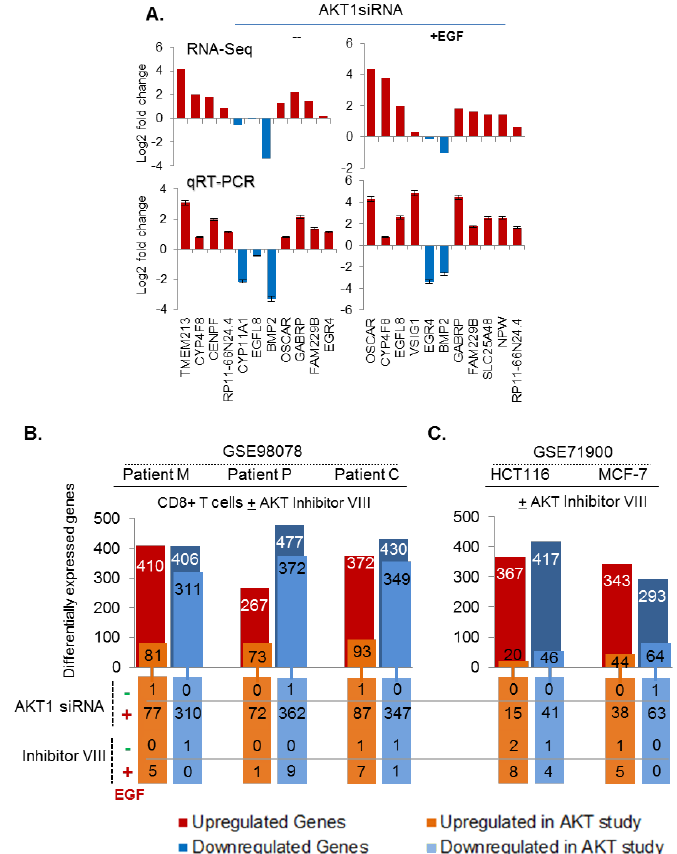
Figure 5. Validation of AKT-dependent modulation of transcriptomes. ( A ) Examples of genes with a similar expression pattern in the RNA-seq data and RT-PCR validation studies; ( B ) comparative analysis of RNA sequencing data presented here with AKT inhibitor VIII-modulated transcriptome from the accession number GSE98078. The numbers on the top of the bar show the overlap with upregulated and downregulated genes as compared to the individual sample; the lower part of the diagram shows the number of gene with unique overlap with AKT inhibitor VIII treated samples with and without EGF stimulation; and ( C ) the comparative analysis of the RNA-seq data presented here with the effect of AKT inhibitor VIII on the gene expression in colorectal cancer HCT116 and breast cancer MCF-7 cells under the accession number GSE71900. Only the genes showing at least 1.5 fold change with a p -value < 0.05 are considered from all the studies.